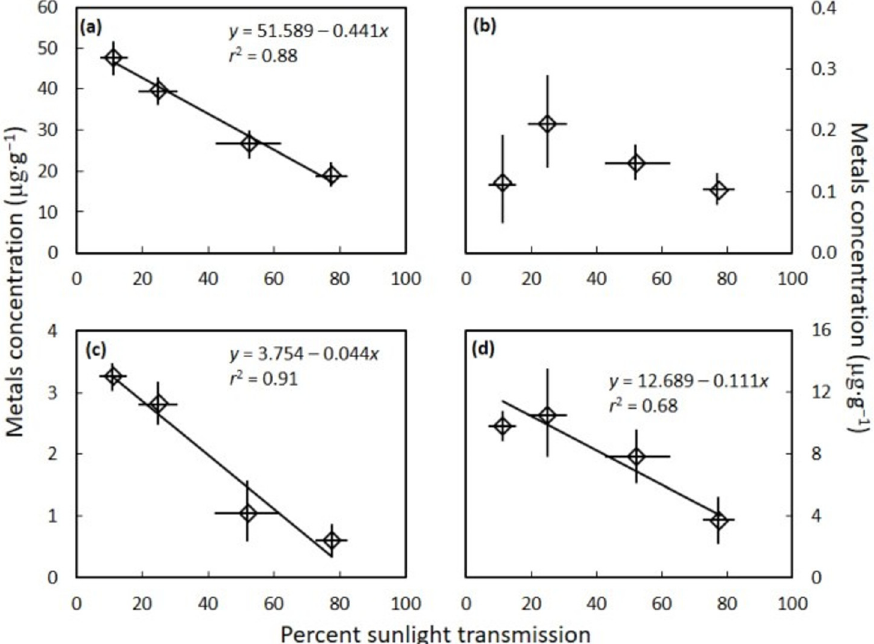
Figure 2. The influence of habitat sunlight transmission on Cycas micronesica seed gametophyte metal concentration. ( a ) aluminum; ( b ) cobalt; ( c ) nickel; and ( d ) selenium. Mean ± standard devia- tion.